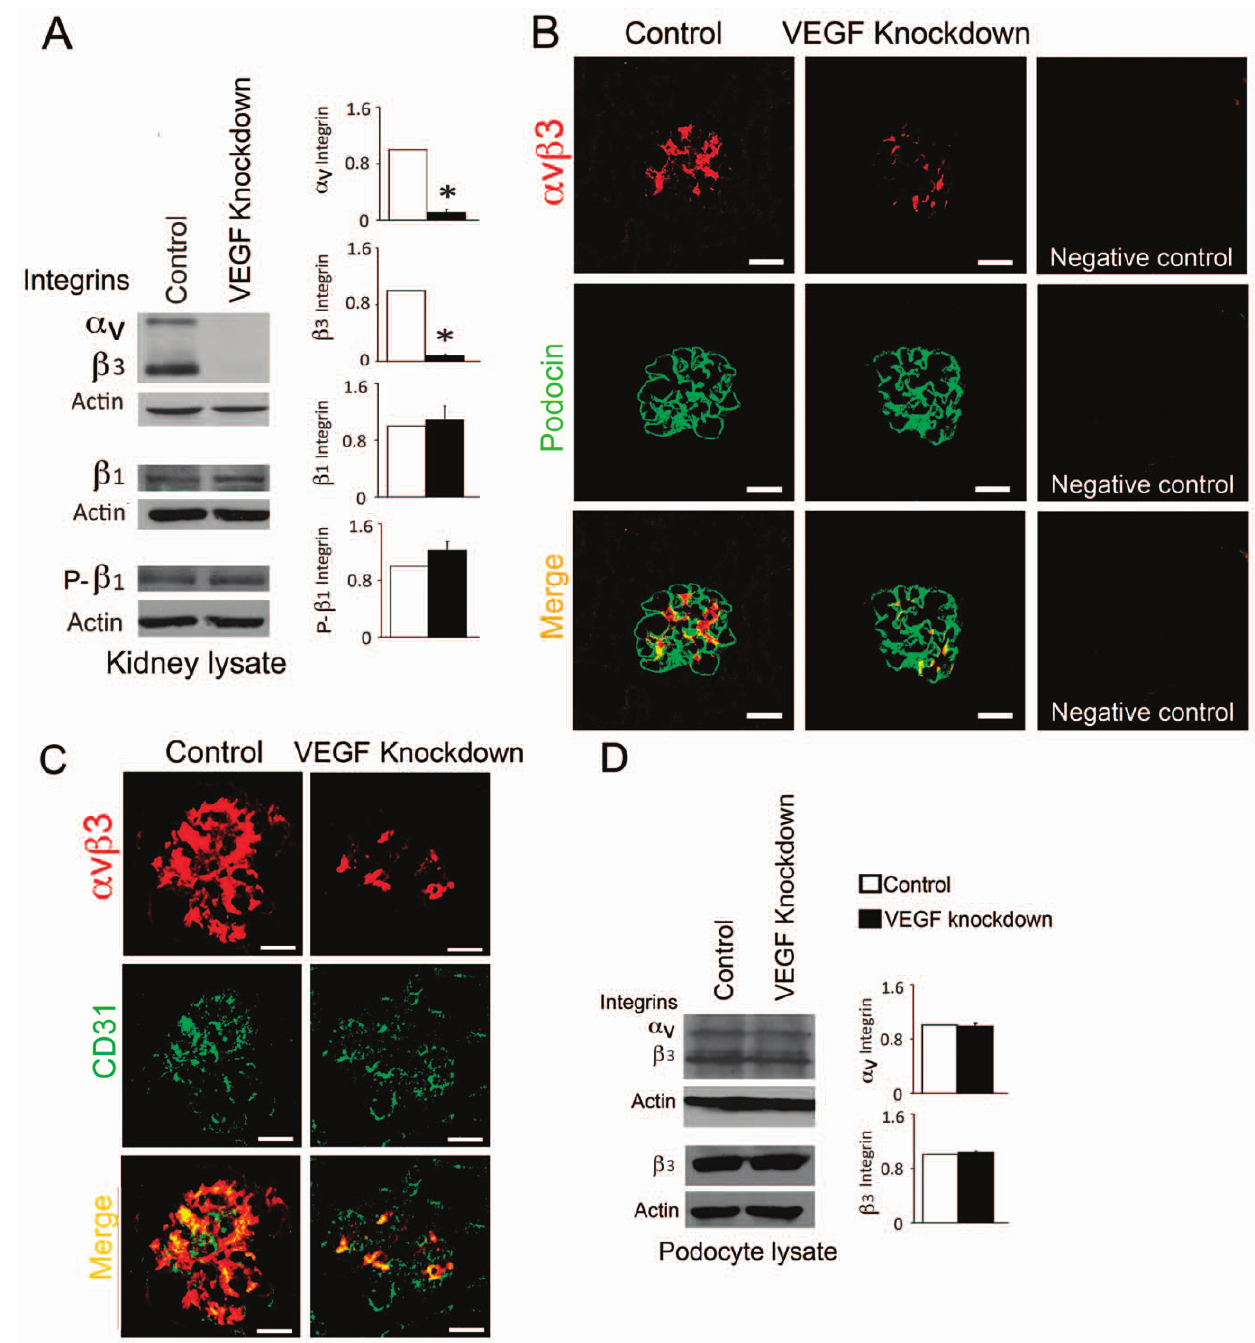
Figure 6. Podocyte VEGF knockdown downregulates endothelial alpha V beta 3 integrin. (A) Representative immunoblots show decreased alpha V beta 3 integrin in VEGF knockdown kidney lysate, while beta 1 integrin and S 785 - beta 1 integrin (P- b 1) remain at control levels. (B) Dual- immunostaining shows decreased alpha V beta 3 integrin in VEGF knockdown glomeruli, with minimal co-localization with podocin, which is stable; negative controls shown. (C) Dual-immunostaining shows alpha V beta 3 integrin and CD31 (endothelial marker) co-localization in control glomeruli, while in VEGF knockdown alpha V beta 3 integrin decreases and CD31 does not. Note that immunoreactive alpha V beta 3 signals appear higher than in (B) due to permeabilization required to detect CD31. (D) Representative immunoblots show alpha V beta 3 integrin and beta 3 integrin levels in podocyte lysate unchanged upon VEGF knockdown. In (A) and (D) bar graphs show densitometric analysis, data are expressed as mean 6 SEM fold change as compared to controls, n $ 3, * indicate P , 0.05 vs. control. In (B) and (C) scale bars=20 m m. doi:10.1371/journal.pone.0040589.g006 We generated a transgenic mouse model to knockdown VEGF processes in vivo in a reversible manner, at difference from in podocytes by doxycycline-regulated shRNA, enabling to study permanent loss of VEGF expression in knockout models. An the pathogenic effects of local VEGF downregulation and repair immortalized podocyte cell line derived from these mice silences